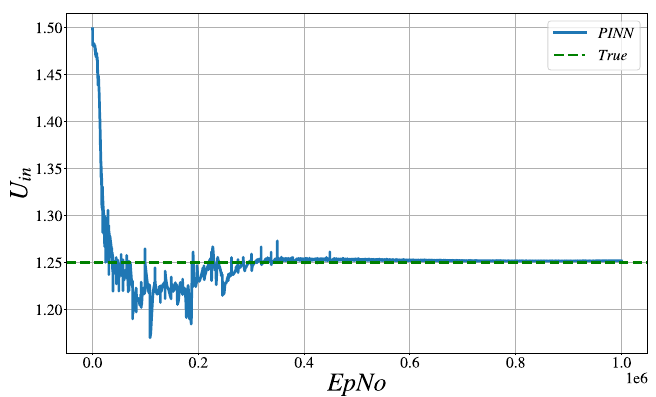
Fig. 9 The PINN approximation of the U (cid:13) in in the case of forces data